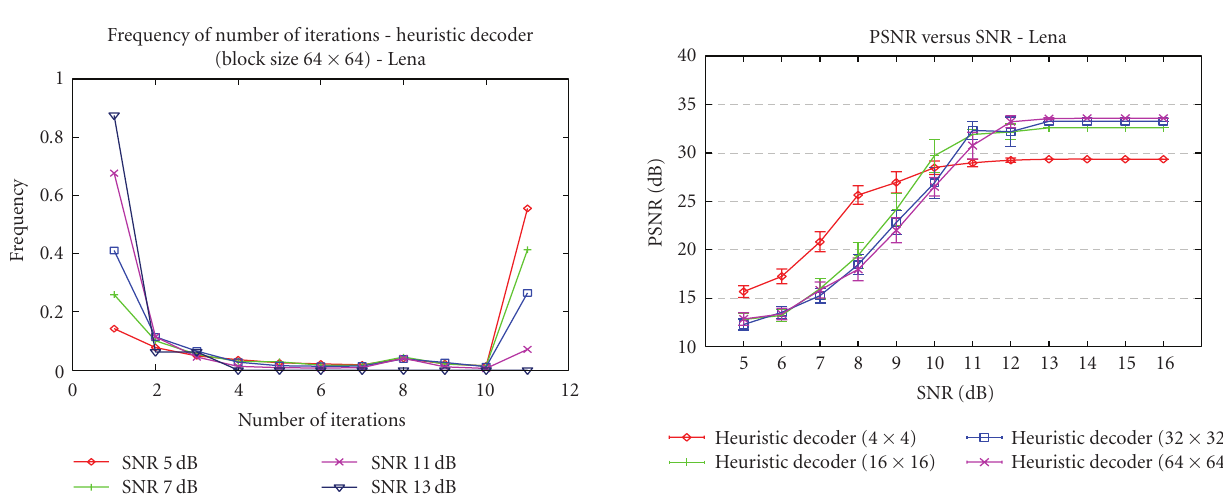
Figure 8: Implications of di ff erent code blocks (heuristic